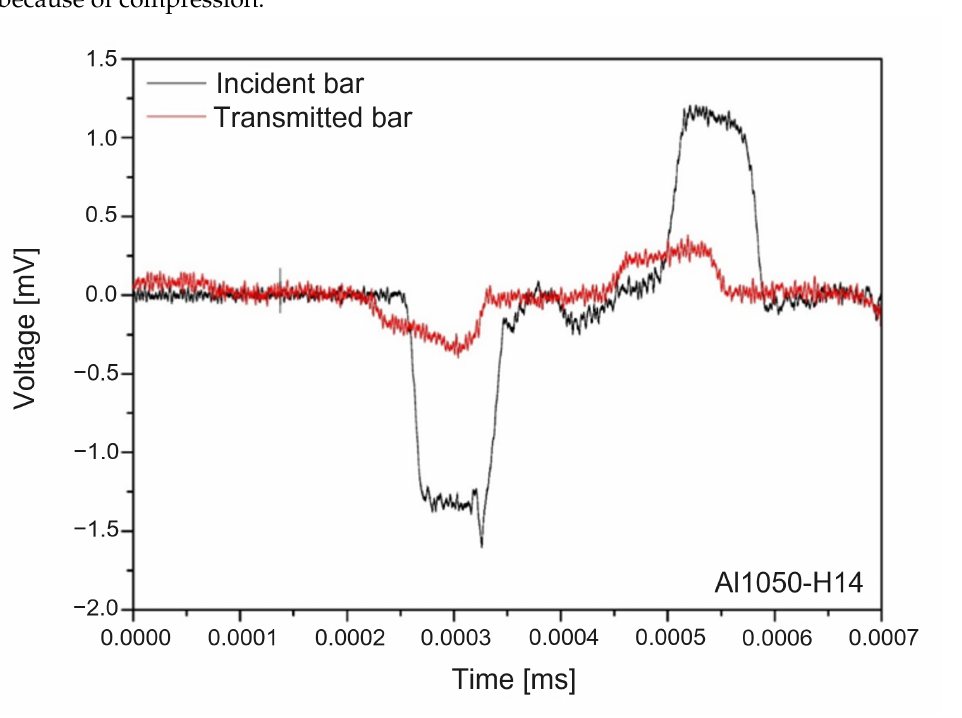
Figure 25. Measured incident and transmitted waves with aluminum